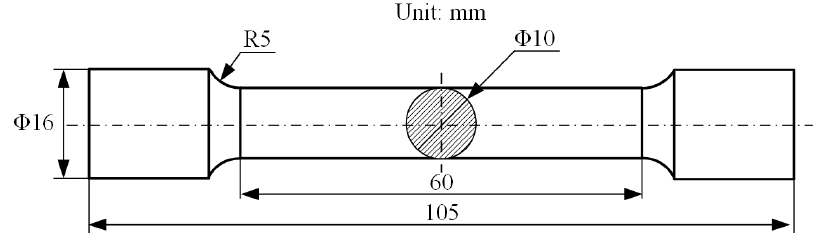
Figure 3. The size of the tensile specimen.